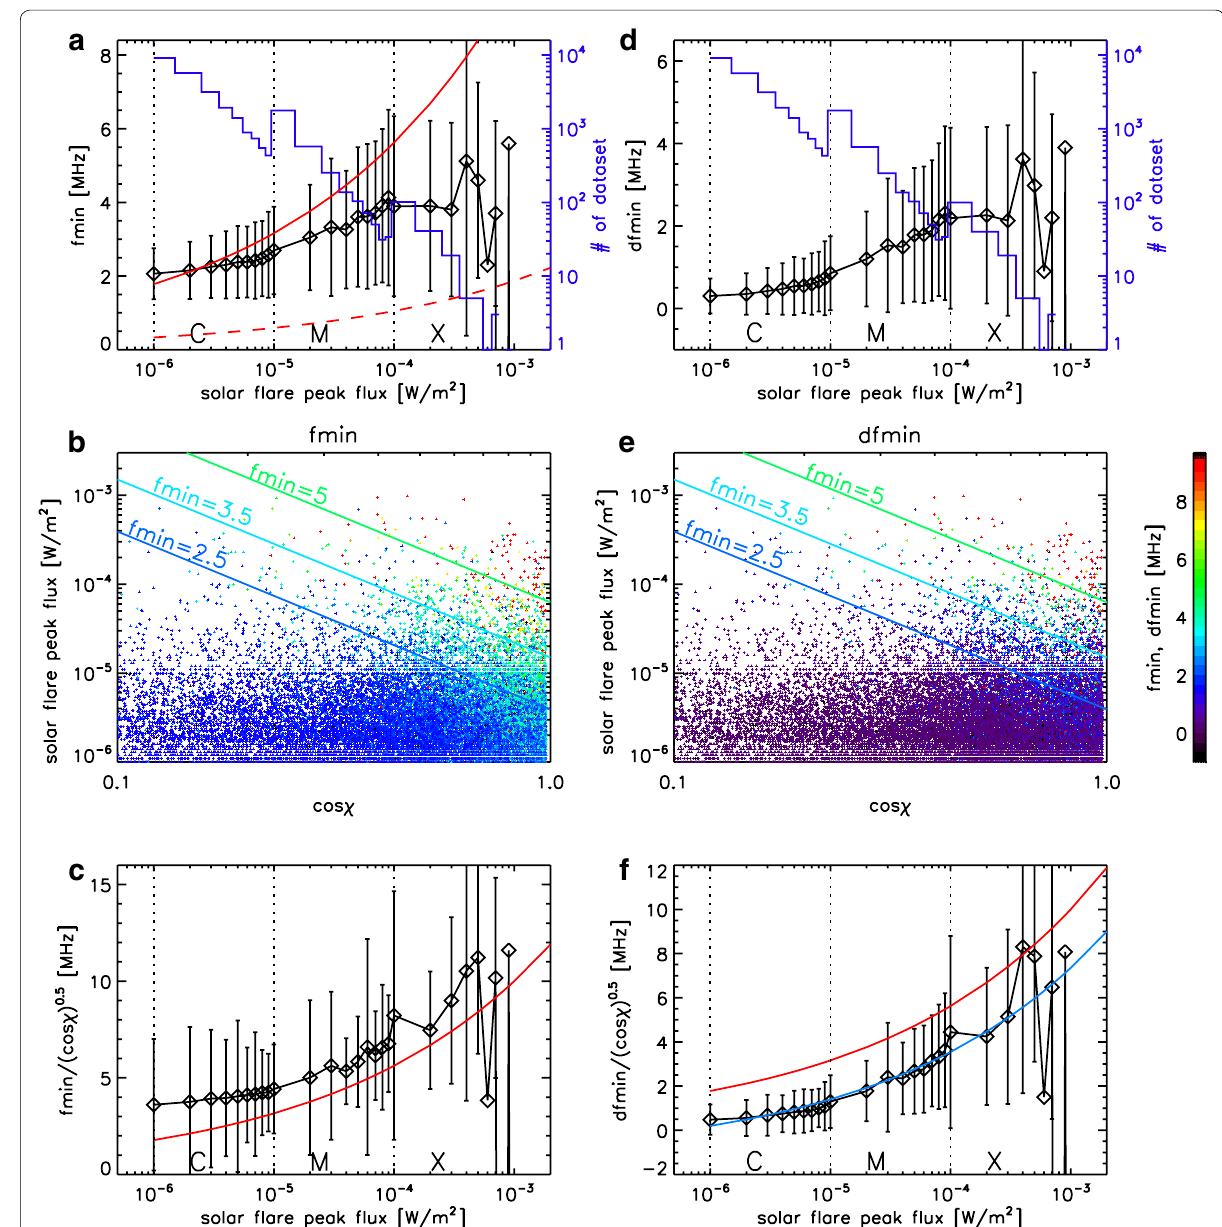
Fig. 3 Maximum a f min and d d f min values within 1 h of solar flare as a function of solar flare peak flux, b f min and e d f min values as a function ± of solar flare peak flux and cos χ, where χ is the solar zenith angle, and c f min and f d f min normalized by (cos χ) 0.5 as a function of solar flare peak flux. The total number of events for this analysis is shown by a histogram with blue lines using the right y -axis scale in Fig. a, d. f min and d f min values respectively in b, e are distinguished by the same color from the color bar on the right side, and blue, light blue, and green lines show Eq. (1) for f min 2.5, 3.5, and 5 MHz, respectively. Vertical solid lines in a, c, d, and f show the standard deviation, 1σ. In a, the red curve shows Eq. (1) = ± at the subsolar point (χ 0°) and the dashed red line shows Eq. (1) at χ 88°. Solid red curves in c and f show the normalized Eq. (1), and the blue = = curve in f shows best-fitted function represented by Eq.